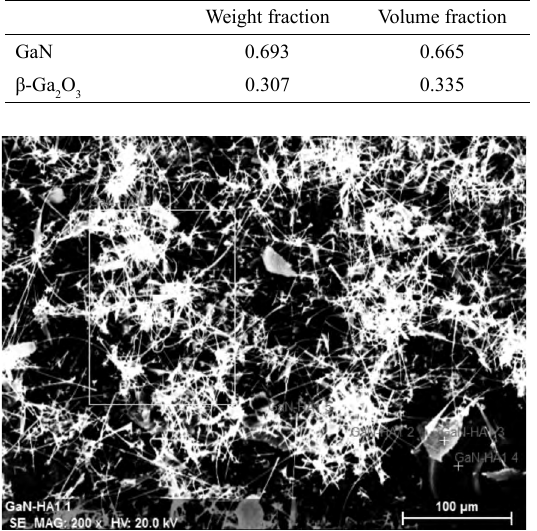
Figure 4. SEM image of sample S-0.10. An irregular morphology is observed, some particles and wire-like structures were grown on the substrate surface.